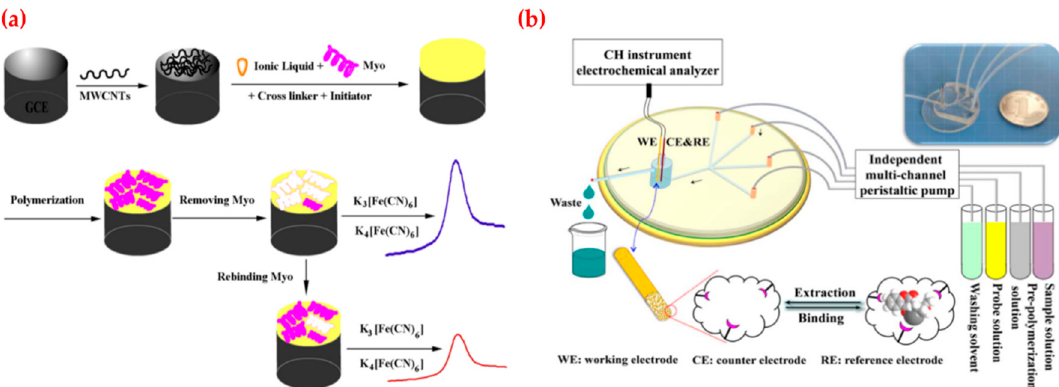
Figure 6. ( a ) Myoglobin-imprinted sensor and ( b ) structure, photo and application of the microfluidic sensor. Republished with permission from [117,118]; permission conveyed through the Copyright Clearance Center, Inc.